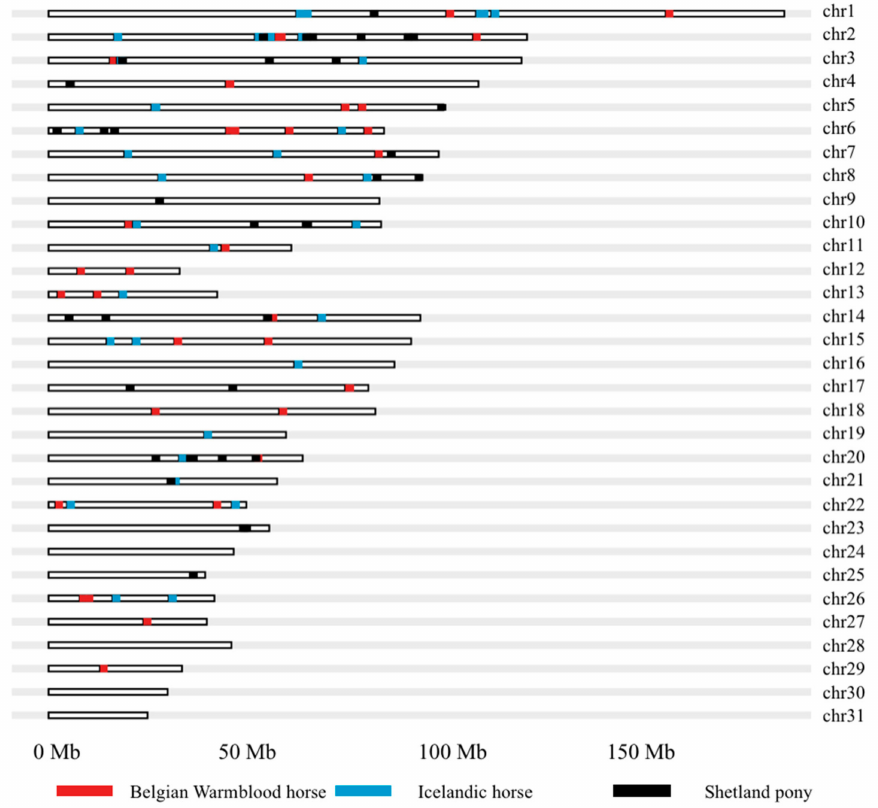
Figure 2. Karyogram from the genome-wide association (GWA) analyses indicating the location of 50 SNPs per breed most significantly associated with IgE levels against Culicoides spp. allergens in Belgian Warmblood horses, Icelandic horses, and Shetland